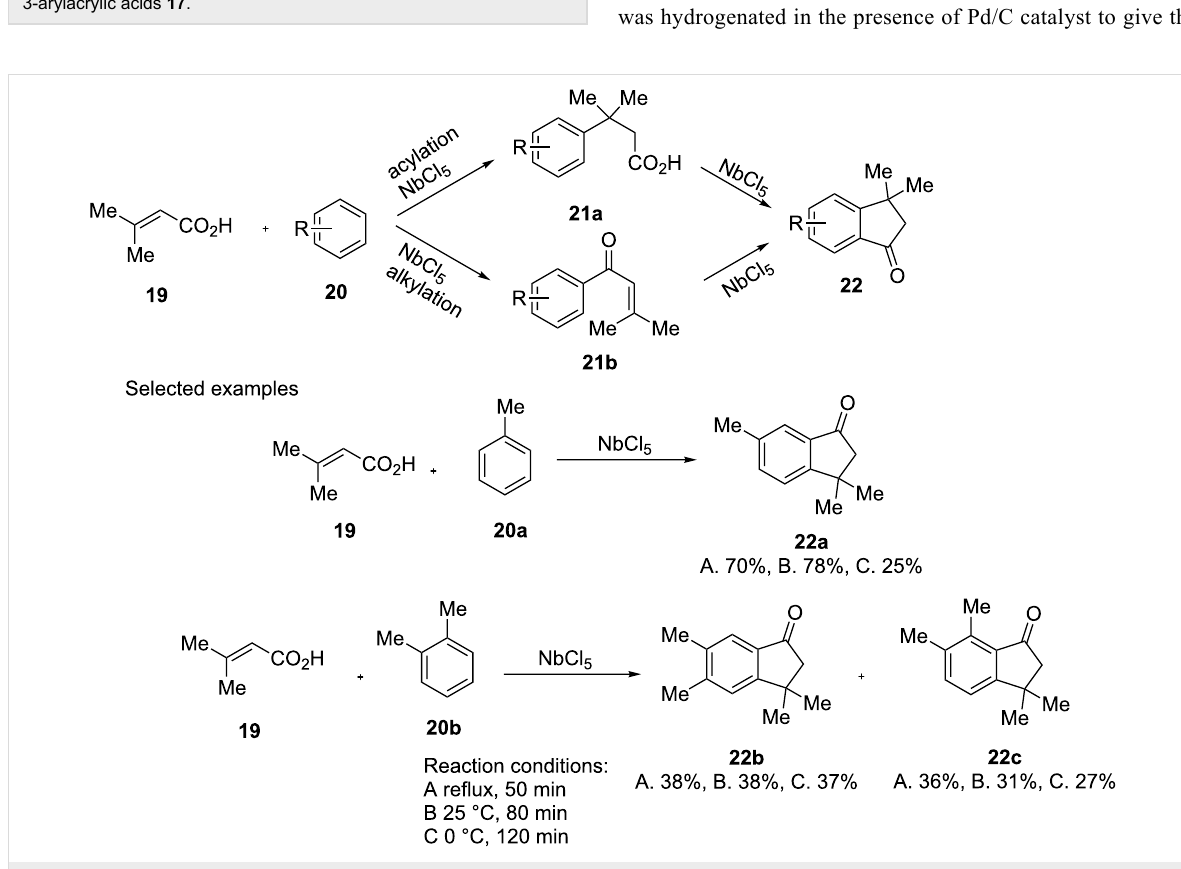
Scheme 8: The NbCl 5 -induced one-step synthesis of 1-indanones 22 .